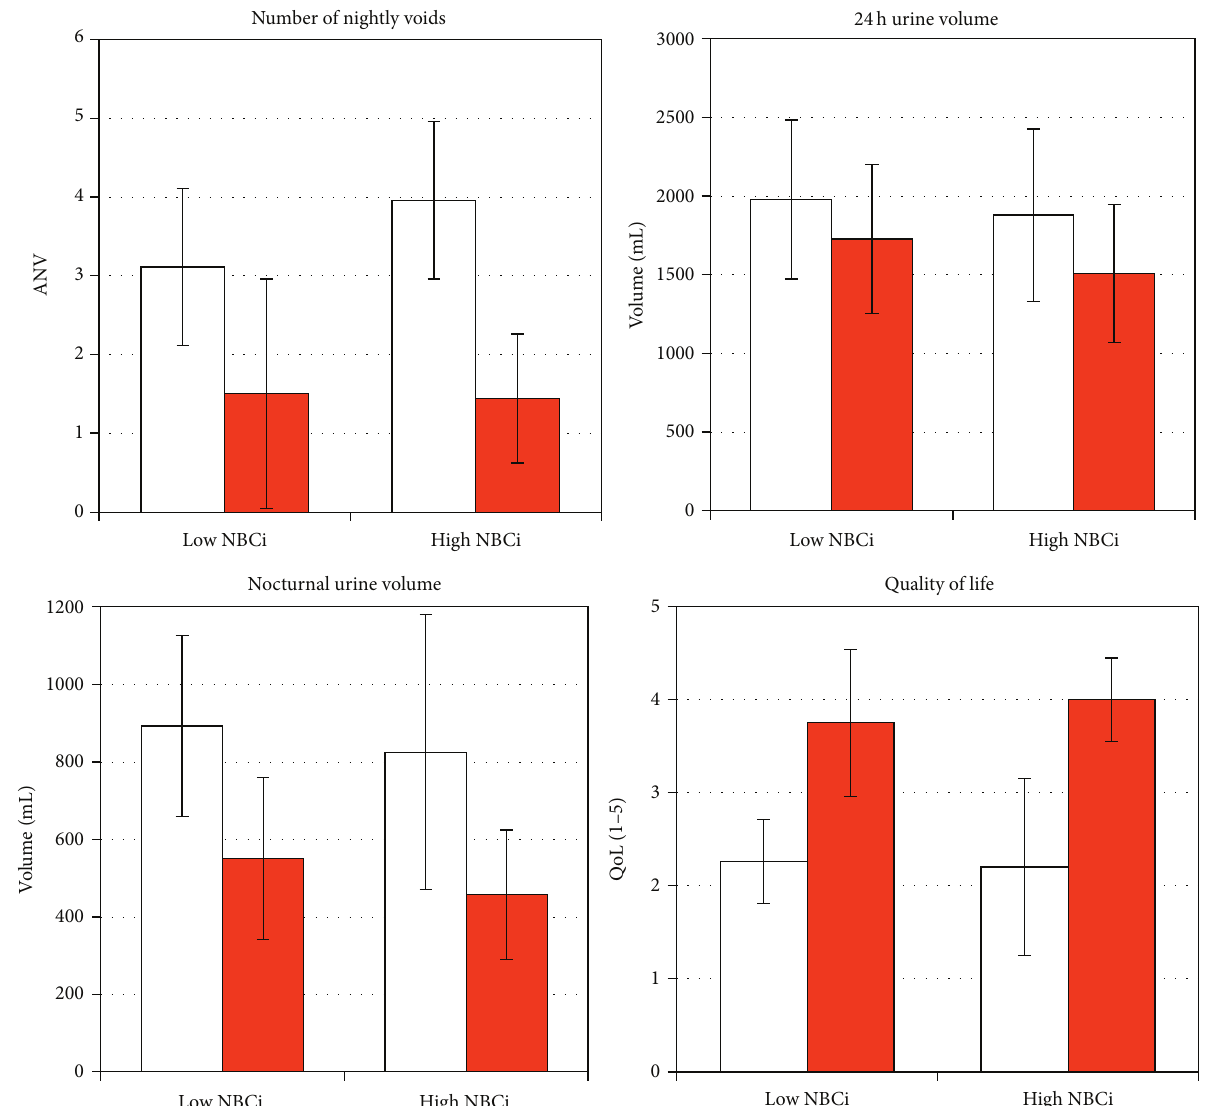
Figure 1: Effect of desmopressin therapy according to normal or high pretreatment nocturnal bladder capacity index (NBCi) on number of nightly voids, 24-h urine volume, nocturnal urine volume, and quality of life. Each pair: first column—before therapy, second column—on therapy. All pre- versus on-therapy values were statistically significantly different (also 24h urine volume, where p was 0.03 for normal NBCi and 0.001 for high NBCi). On therapy, comparison of each two groups showed no significant differences for all four measures.